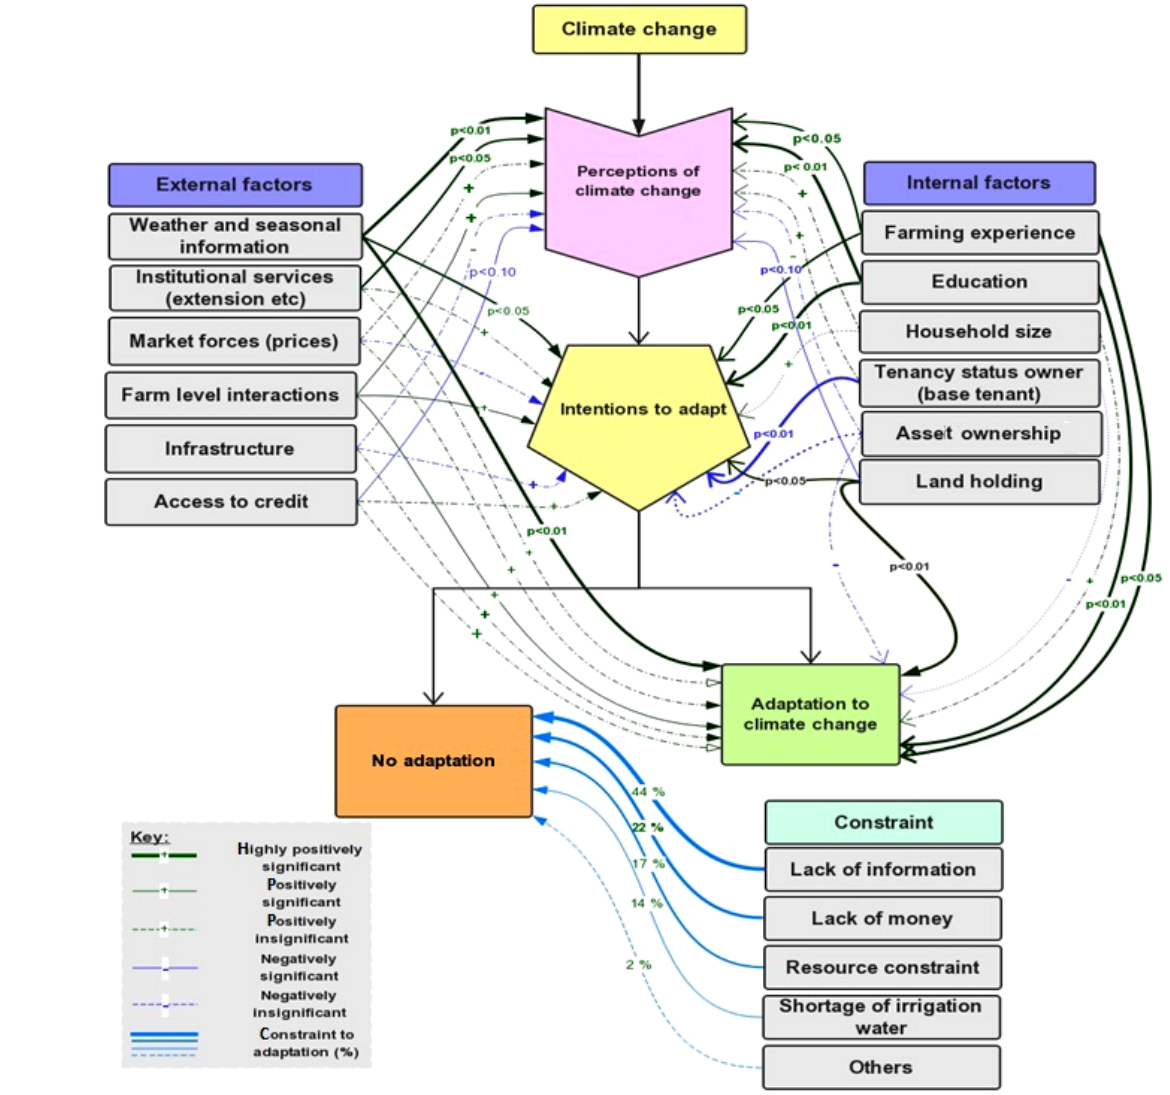
Figure 9. Schematic framework of farmers’ adaptation process in Pakistan (own